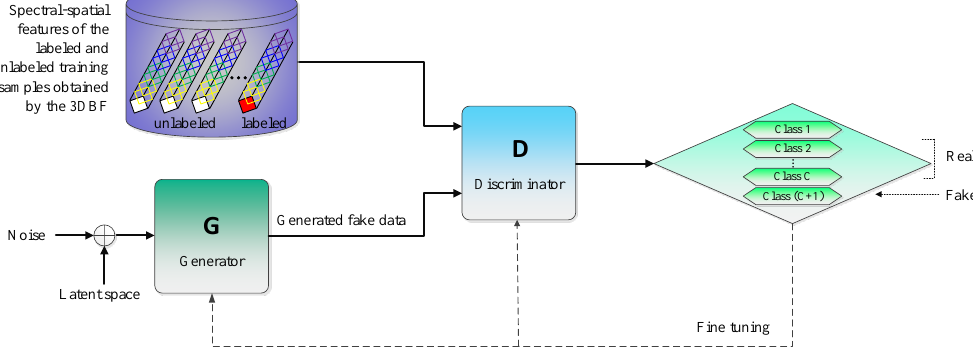
Figure 5. A visual illustration of the semi-supervised hyperspectral classification method by